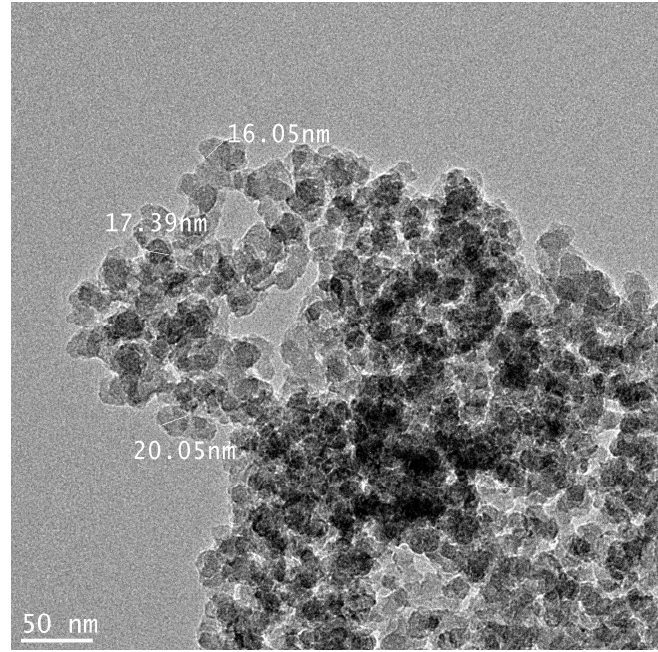
Figure 1. Morphological images of silica NP observed by transmission electron microscopy (TEM). (scale bar = 50 nm).